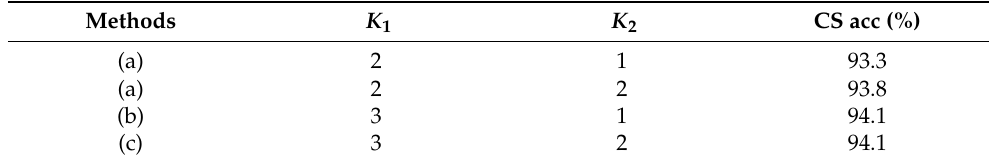
Table 4. Comparison in terms of interaction recognition accuracy of K 1 , K 2 .